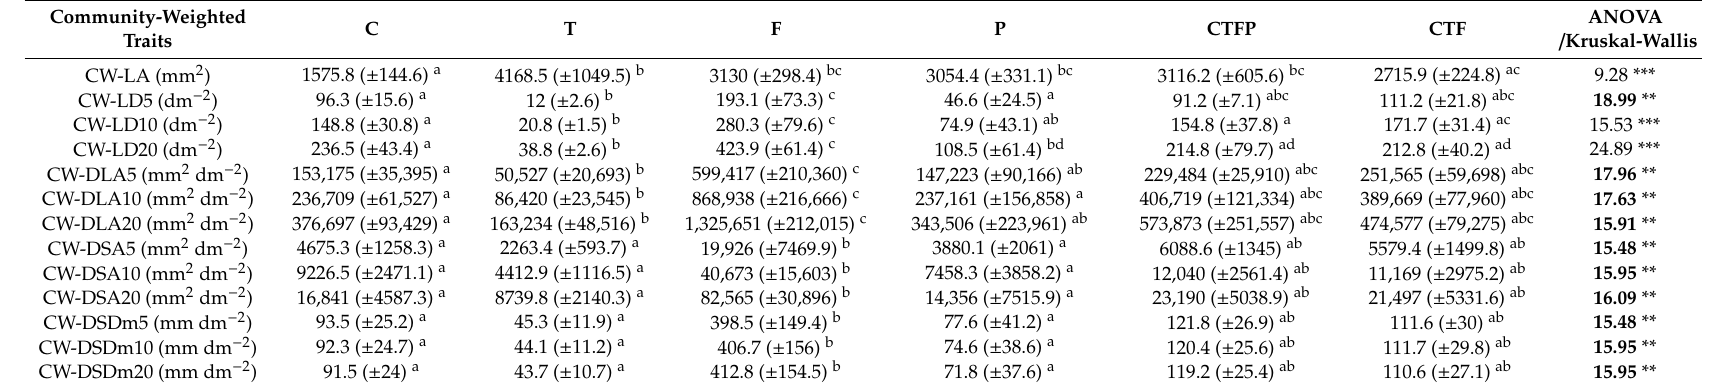
Table 2. Di ff erences in community-weighted traits (CW) for each community